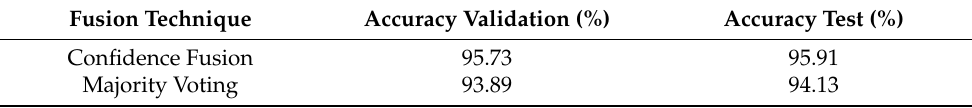
Table 11. Results of trimodal prediction of trust using top 3 performing